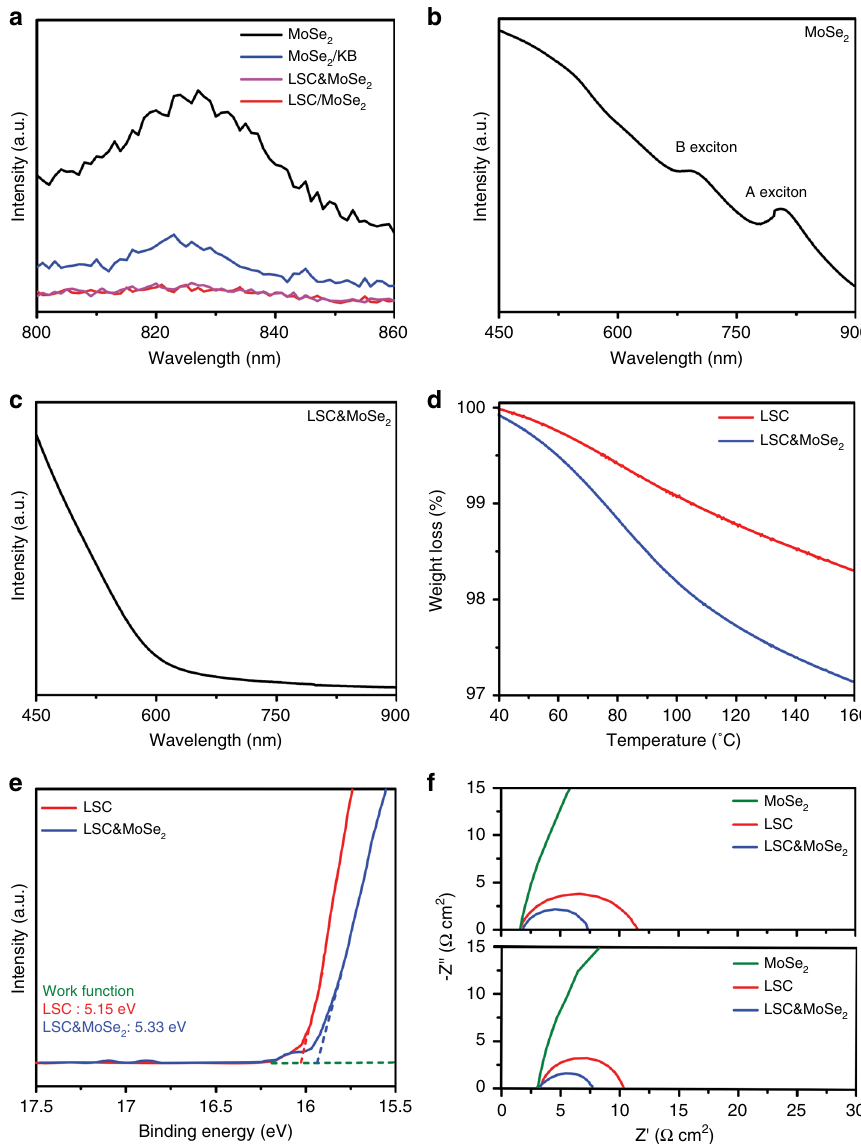
Fig. 3 Analysis of physical properties of LSC&MoSe 2 . Fluorescence emission spectra of a MoSe 2 , MoSe 2 /KB, LSC&MoSe 2 , and LSC/MoSe 2 (The concentration of MoSe 2 in all samples is fi xed as 0.33 mg/mL), illustrating the 2H-phase of the as-prepared MoSe 2 and electron transfers among MoSe 2 , LSC, and KB. UV-vis-NIR spectra of b MoSe 2 , indicating the presence of A and B excitons, which are attributed to direct excitonic transition of K points in the Brillouin zone, and c LSC&MoSe 2 , illustrating its metallic feature. d TGA analysis of LSC and LSC&MoSe 2 pre-exposed to wet-air for 24 h. e UPS valence band spectra of LSC and LSC&MoSe 2 . f Nyquist plots of HER (upper) and OER (lower) of MoSe 2 , LSC, and LSC&MoSe